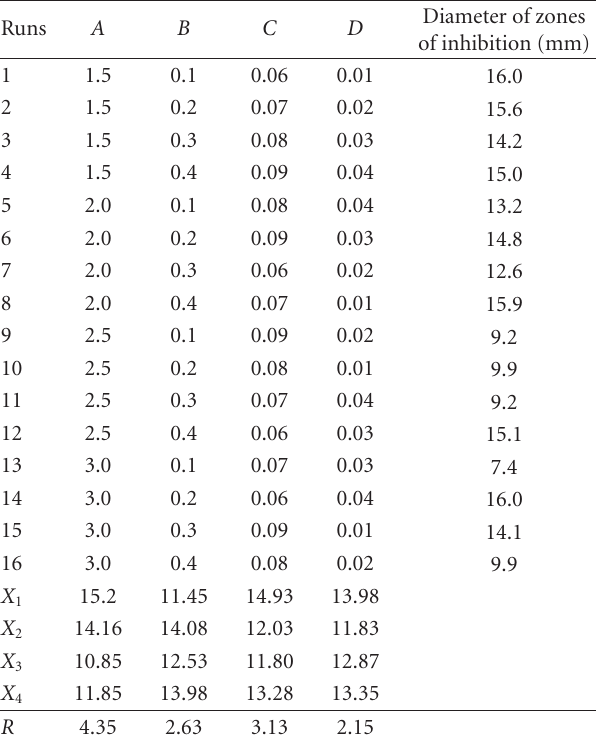
Table 6: Analysis of the results of orthogonal design (L 16 4 5 ) for the optimization of strain Hhs.015 T alternative cultural medium.